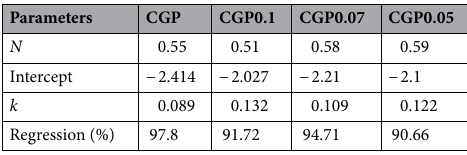
Table 2. Diffusion parameters of CGP hydrogel samples.